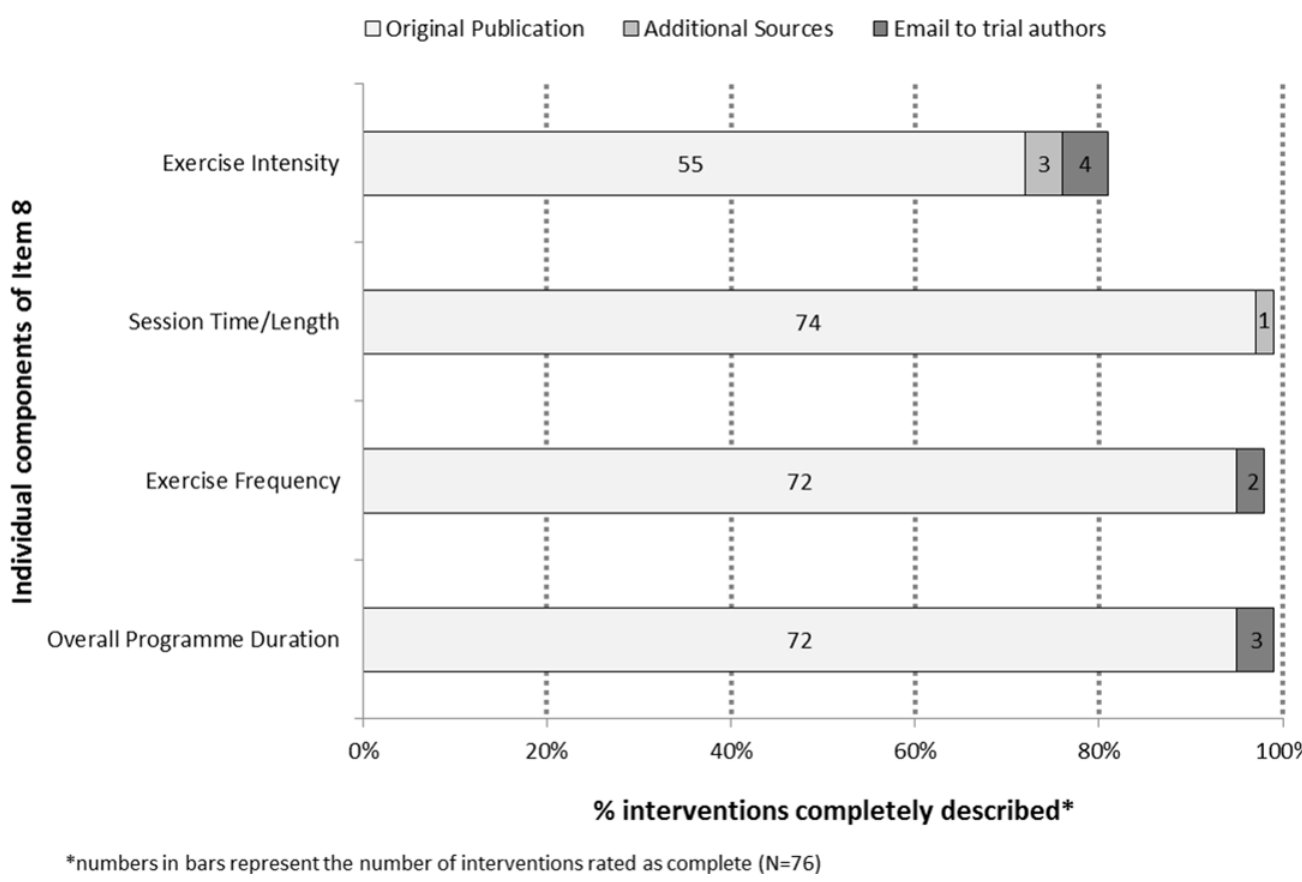
Fig 3. Percentage of interventions which completely reported each component of Item 8 (the When and How Much of exercise) in the main trial publication, after reviewing additional published sources and after contact with trial